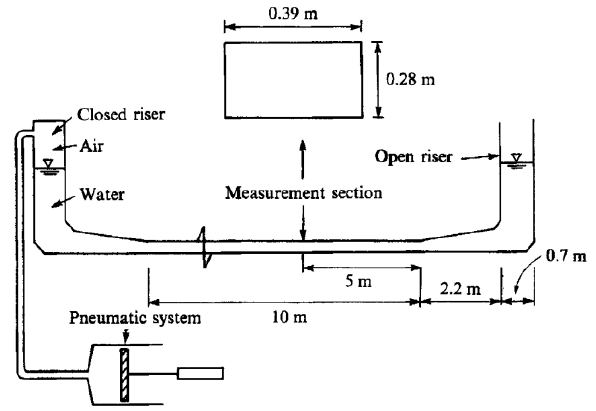
Figure 2. Schematic description of Jensen’s experiment.